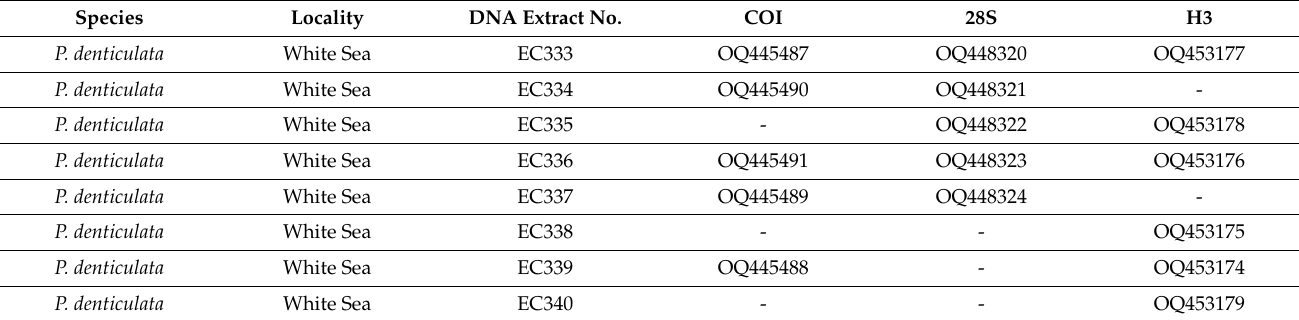
Table 2. Specimens of Philinissima denticulata used for phylogenetic